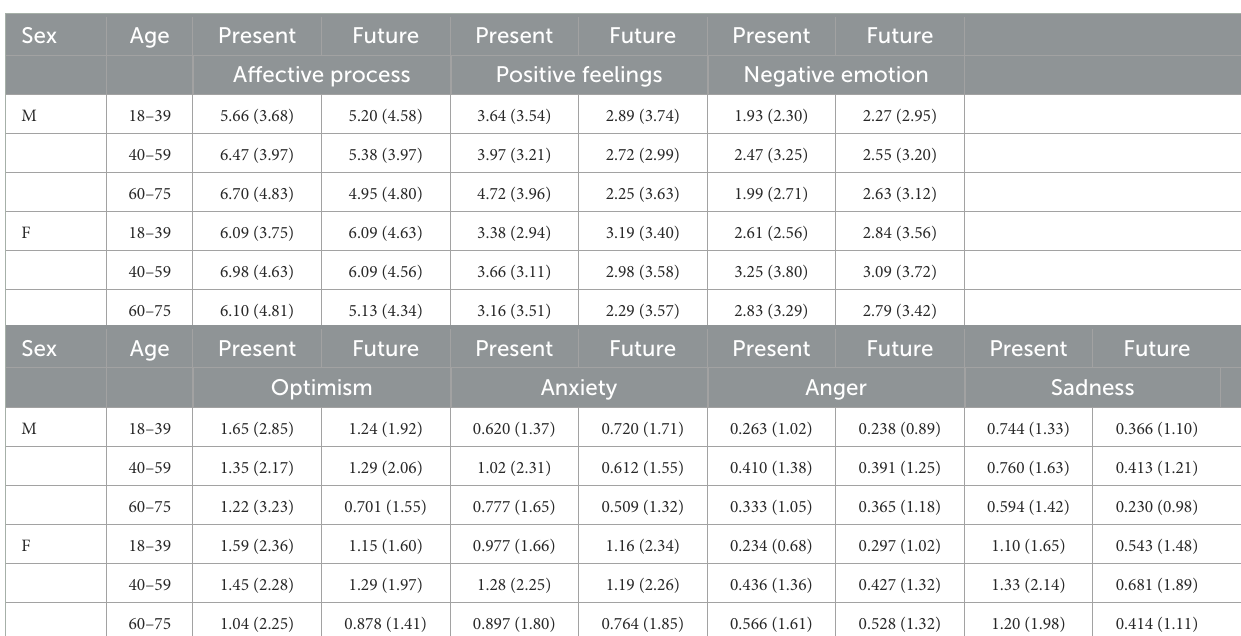
TABLE 4 Descriptive statistics for emotional